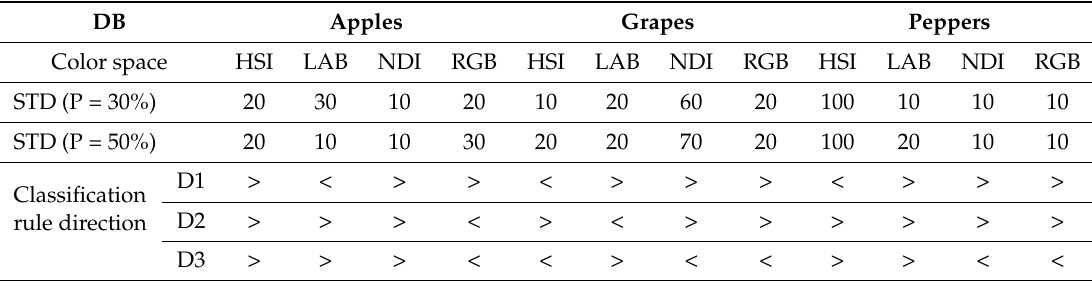
Table 4. STD value chosen for each database and color space. D,